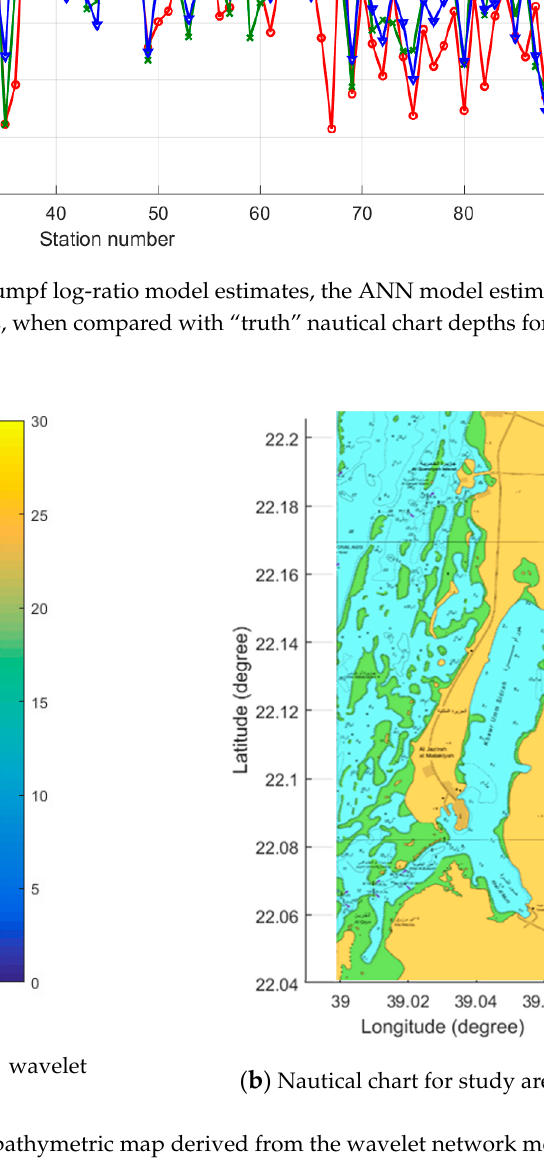
Figure 13. The comparison between the bathymetric map derived from the wavelet network model and the nautical chart for the study area.